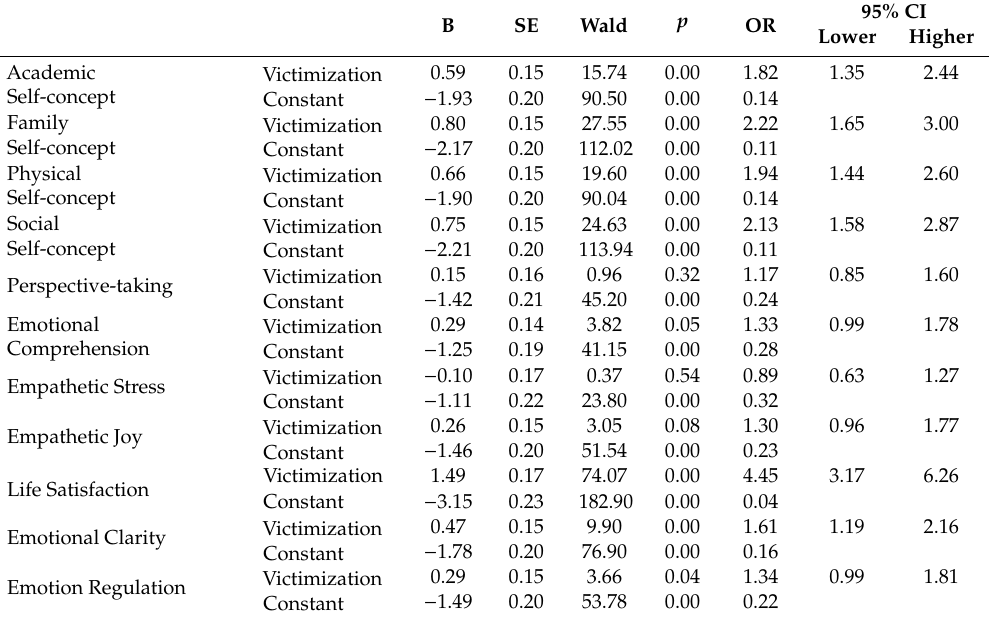
Table 7. Logistic regression with cybervictimization as a predictor of low scores.